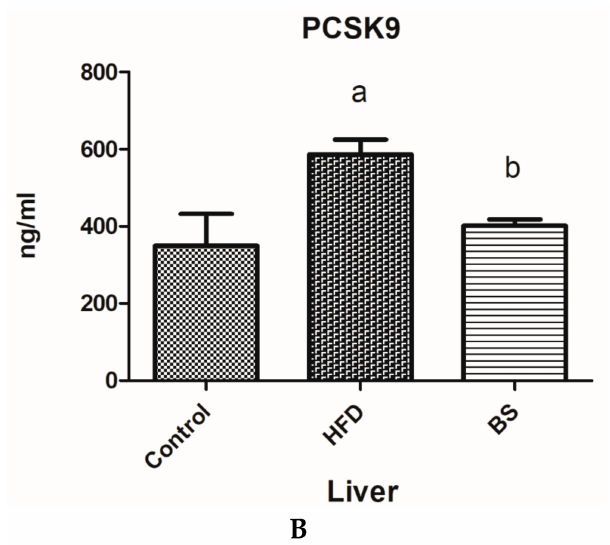
Figure 1. Concentrations of PCSK9 (ng / mL) in blood plasma ( A ) and liver tissue ( B ). Bar heights correspond to averages and error bars represent standard deviations. Statistical significance markers: a—vs. Control ( p < 0.05), b—vs. HFD ( p < 0.05).